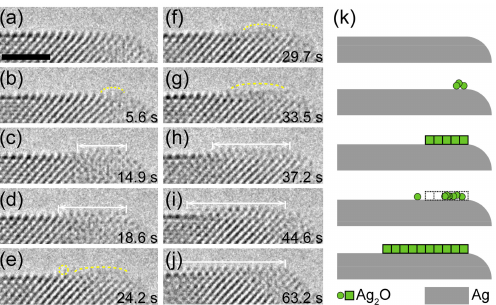
Figure 3. The formation of new layer on the Ag 2 O substrate. ( a – j ) Time-resolved HRTEM images showing the formation of a new Ag 2 O layer on a flat Ag 2 O (110) surface. Dose rate at 9600 e · Å − 2 · s − 1 . An amorphous layer (labeled by yellow dashed line) emerges on the surface ( b ) and then expands laterally with a clear lattice ( c – d ). The extensional layer transforms between amorphous and crystalline and eventually leads to the formation of a larger layer. ( k ) Scheme of the formation of new Ag 2 O layer growth process. Scale bar at 2